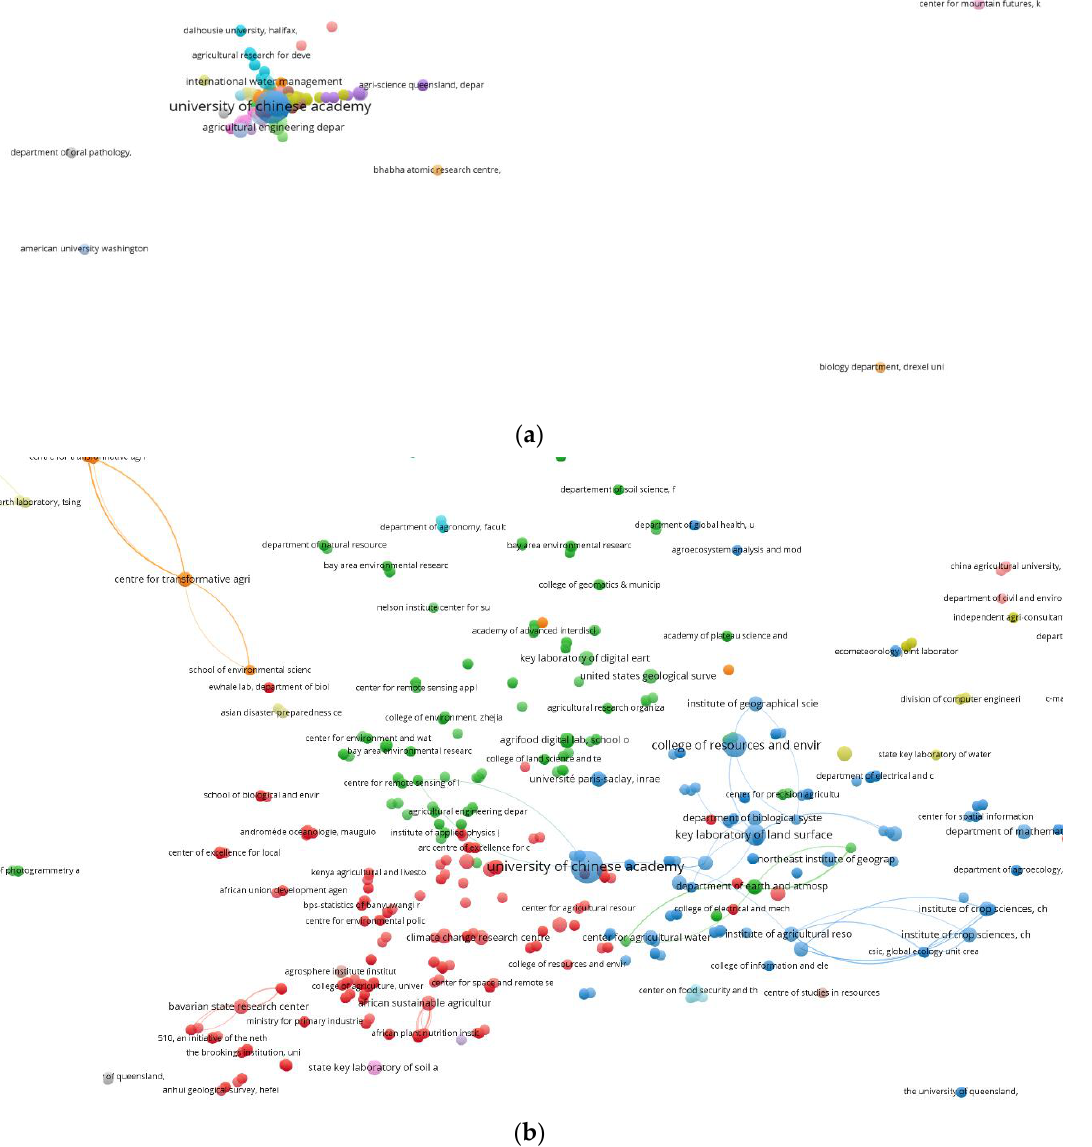
Figure 4. Network visualization map for bibliographic data (bibliographic coupling links and organizations as items), considering full counting and 1 as the minimum number of occurrences of an organization. ( a ) Full network; ( b ) network around some of the items with the highest